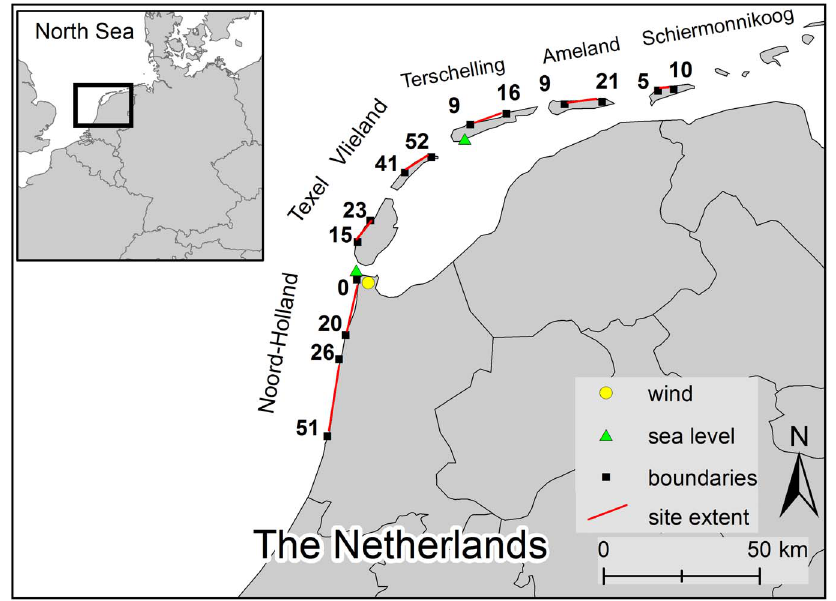
Figure 1. Study areas. Map shows the location of the six coastal sections used in this study within the Netherlands and identifies the location of the wind gauge (KNMI station De Kooy) and two sea-level gauges (Den Helder and West Terschelling). Positions and numbers of beach poles on the section boundaries are indicated. Inset shows the location of the study area within Northwestern Europe.